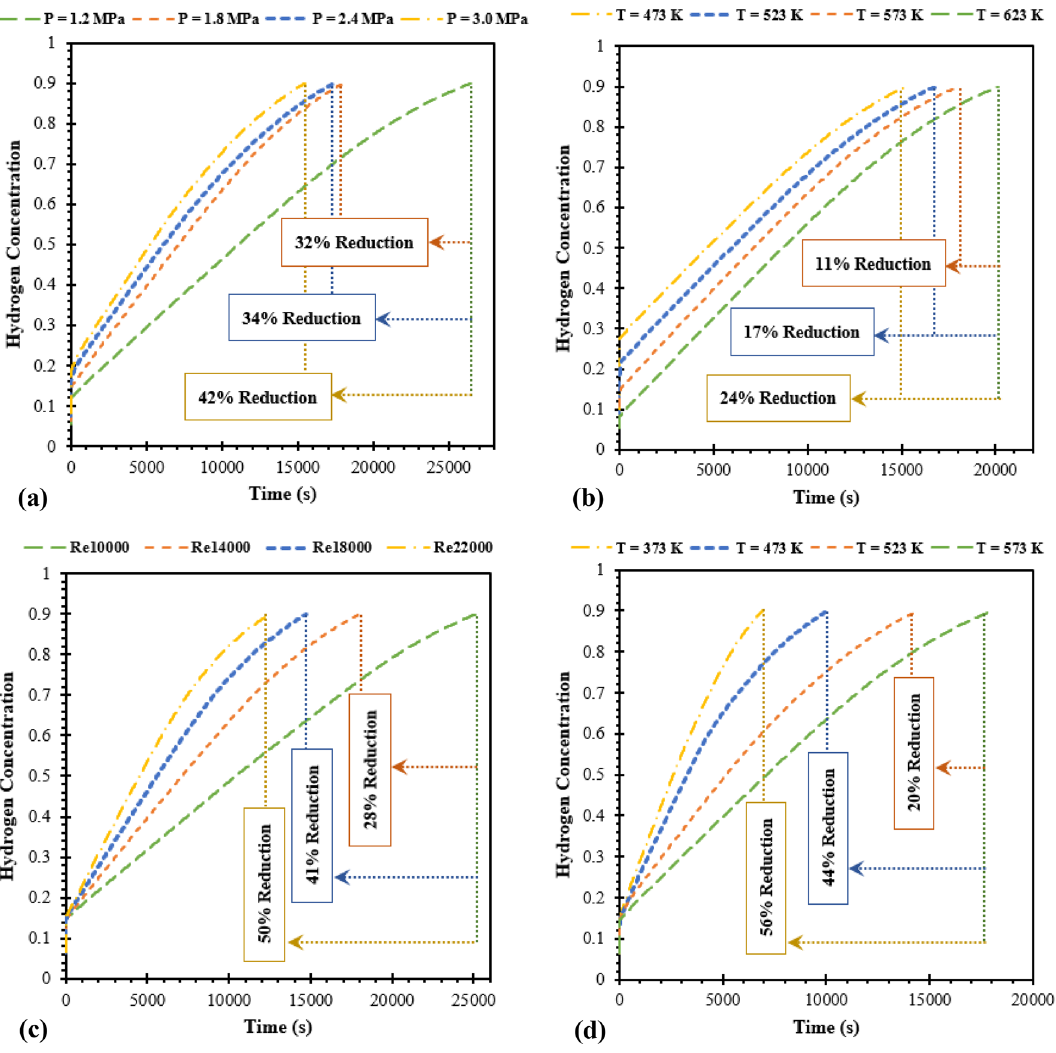
Figure 8. Hydrogen concentration diagram for various operating conditions in the use with the semi- cylindrical coil heat exchanger. ( a ) Loading pressures, ( b ) initial bed temperatures, ( c ) Reynolds numbers of heat transfer fluid, and ( d ) inlet temperatures of heat transfer